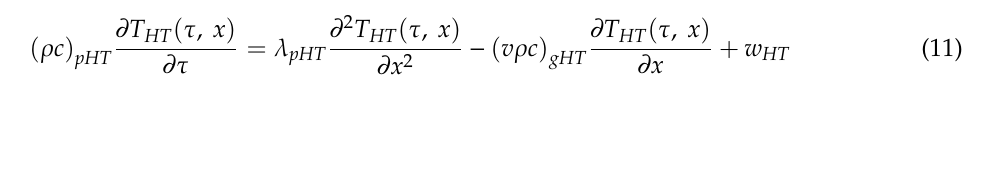
Figure 5. Experimental results of induced exotherm and endotherm by the reactors in the low- temperature channel (right channel). The result verified the formation of leading heat and following objective cooling effect by use of the original heat source input at high-temperature channel shown in Figure 4 right. The accumulated endotherm by arrayed reactors of metal hydride heat pump with superadibatic